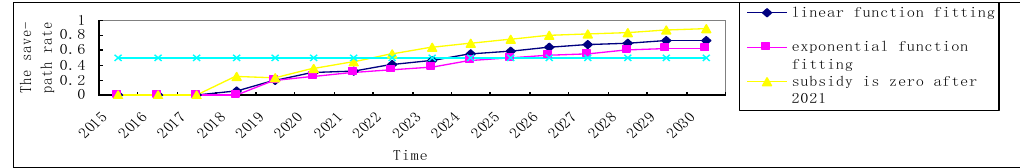
Figure 9. Curve of the save-path rate for three cases.